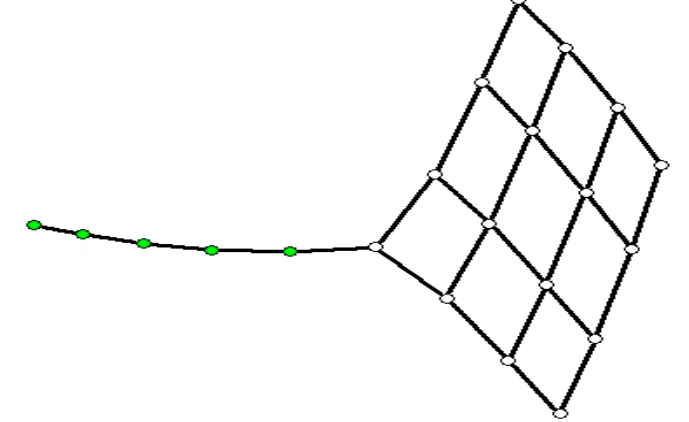
Figure 3. Potential “corner” nodes with minimum eigenvalues are marked by a green color. However, we would prefer potential “corner” nodes also in the corners of the square, not only in the